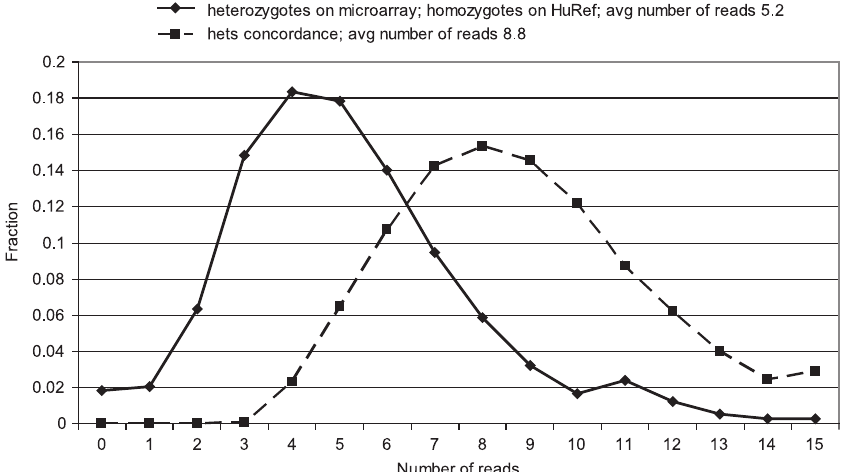
Figure 9. Distribution of HuRef Read-Depth Coverage for Genotyped SNPs Distribution plot of number of underlying reads (average number of reads ¼ 8.8) in HuRef heterozygous SNPs confirmed by the Affymetrix and Illumina genotyping platforms. This is compared to a distribution (average number of reads ¼ 5.2) for SNP detected by the platforms but missed in the HuRef assembly.